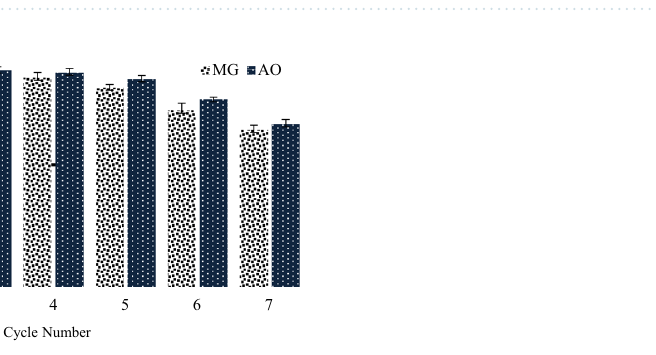
Figure 5. Response surface plots of removal of (a,b) MG and (c,d) AO.